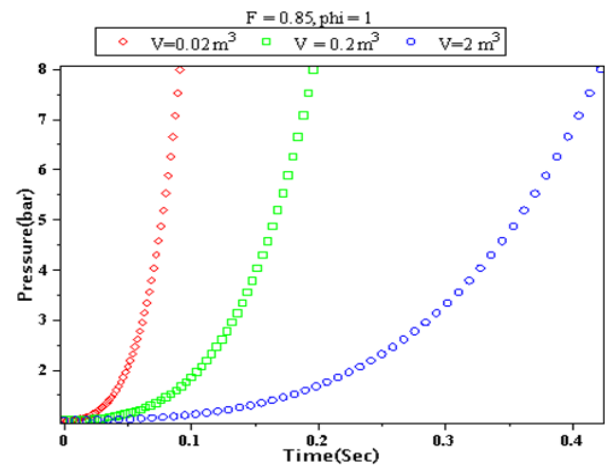
Fig. 3. Effect of vessel size on